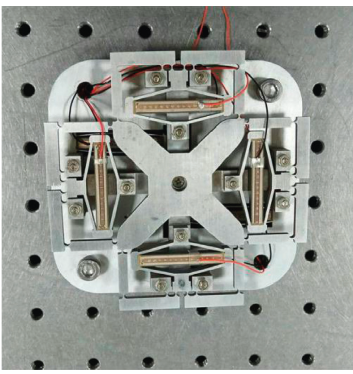
Figure 16: Prototype of the XYθ